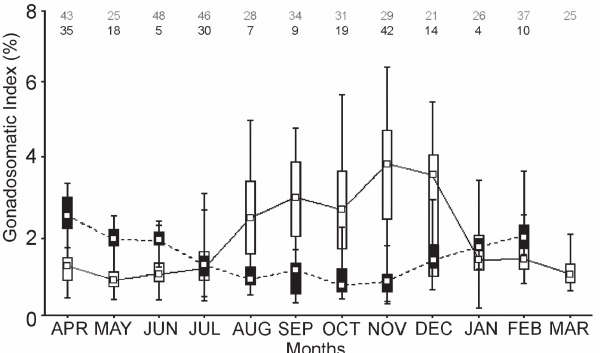
Fig. 7. Monthly variation of the gonadosomatic index (GSI) of Sympterygia bonapartii from San Matías Gulf (Argentina). Mature males (■) and mature females (□). Boxes indicate the percentiles 25-75%; the inner square indicates the median value and bars the range of data distribution. The number of individuals analysed is given in dark grey for females and black for males.